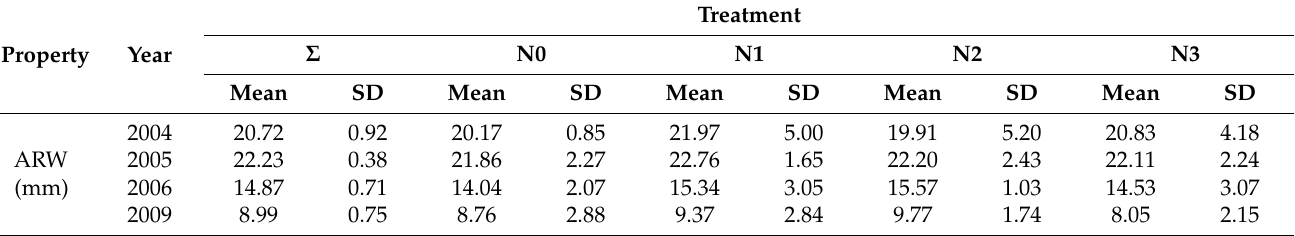
Table 5. Descriptive statistics for the juvenile wood annual ring widths (ARW) of the clone ‘Villafranca’ in different years.